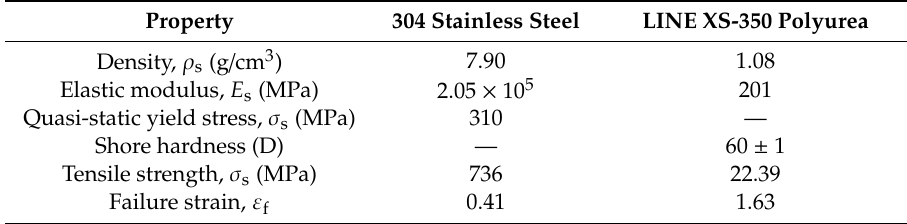
Table 1. Quasi-static material parameters of 304 stainless steel and LINE XS-350 polyurea. Table 1. Quasi ‐ static material parameters of 304 stainless steel and LINE XS ‐ 350 polyurea.